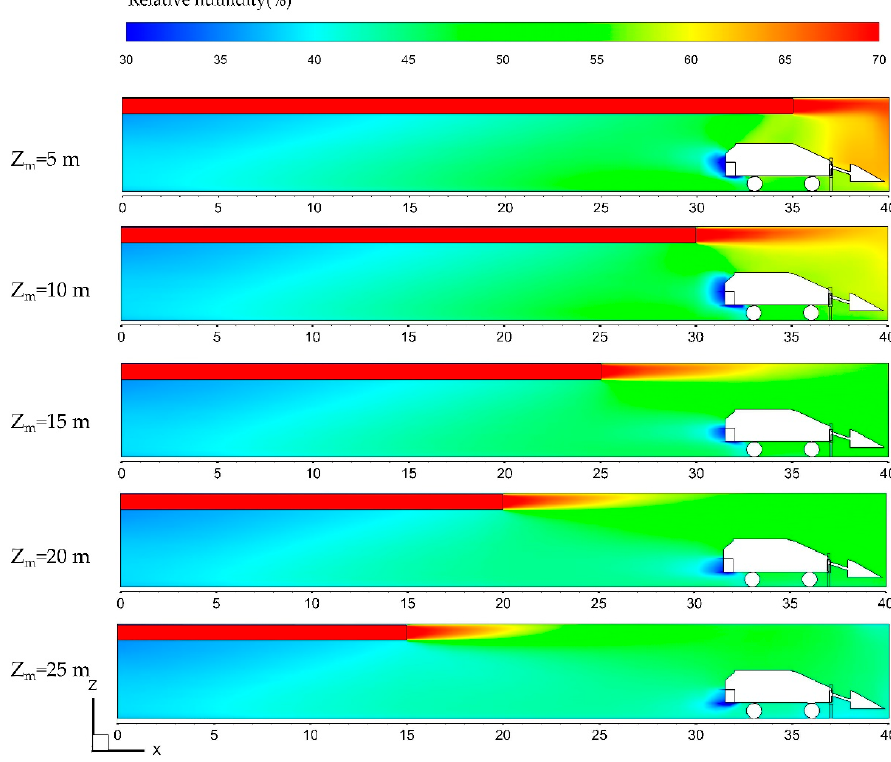
Figure 17. Airflow relative humidity distributions in plane A when Z m = 5 m, Z m = 10 m, Z m = 15 m, Z m = 20 m, and Z m = 25 m.